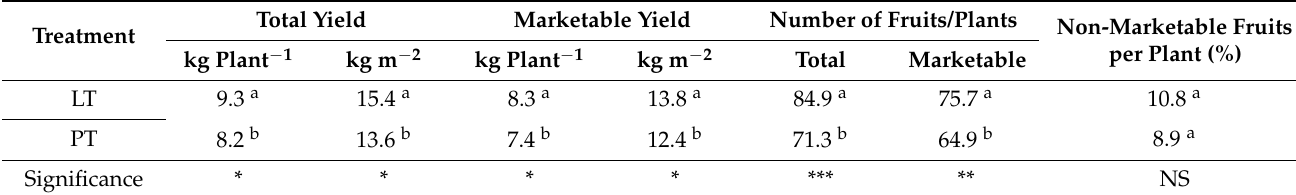
Table 6. Effect of training methods on cucumber plant yield and yield components.